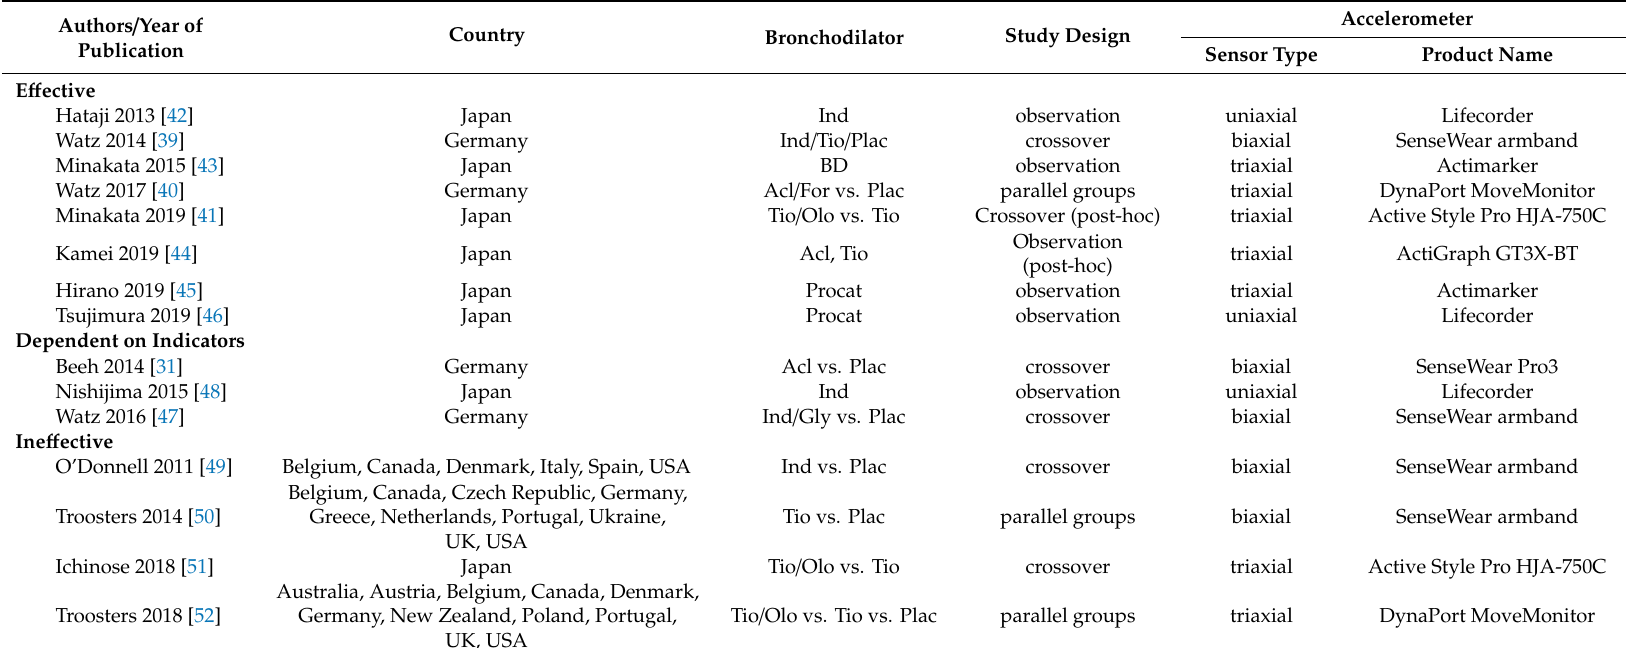
Table 2. Methodological details of the